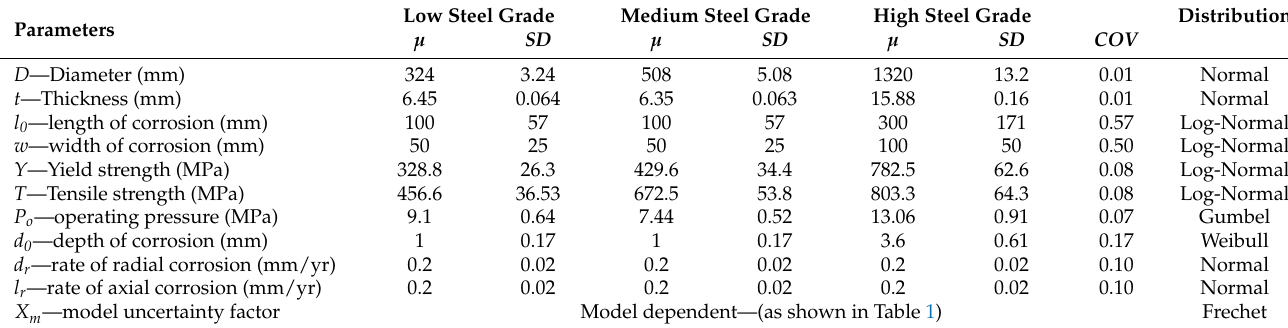
Table 2. Stochastic models of random variables of the design equation.